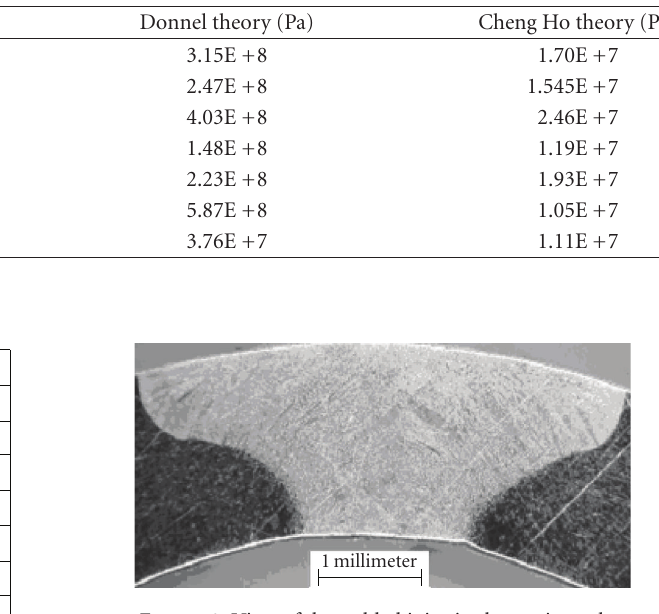
Figure 2: View of the welded joint in the section